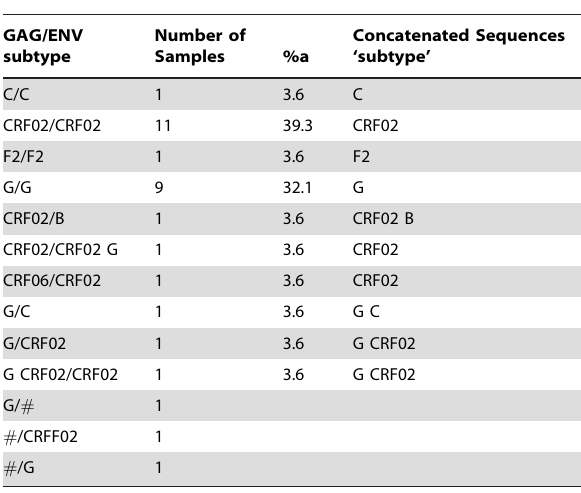
Table 1. Genetic diversity of HIV-1 isolates from antiretroviral-naive pregnant women from North-Central